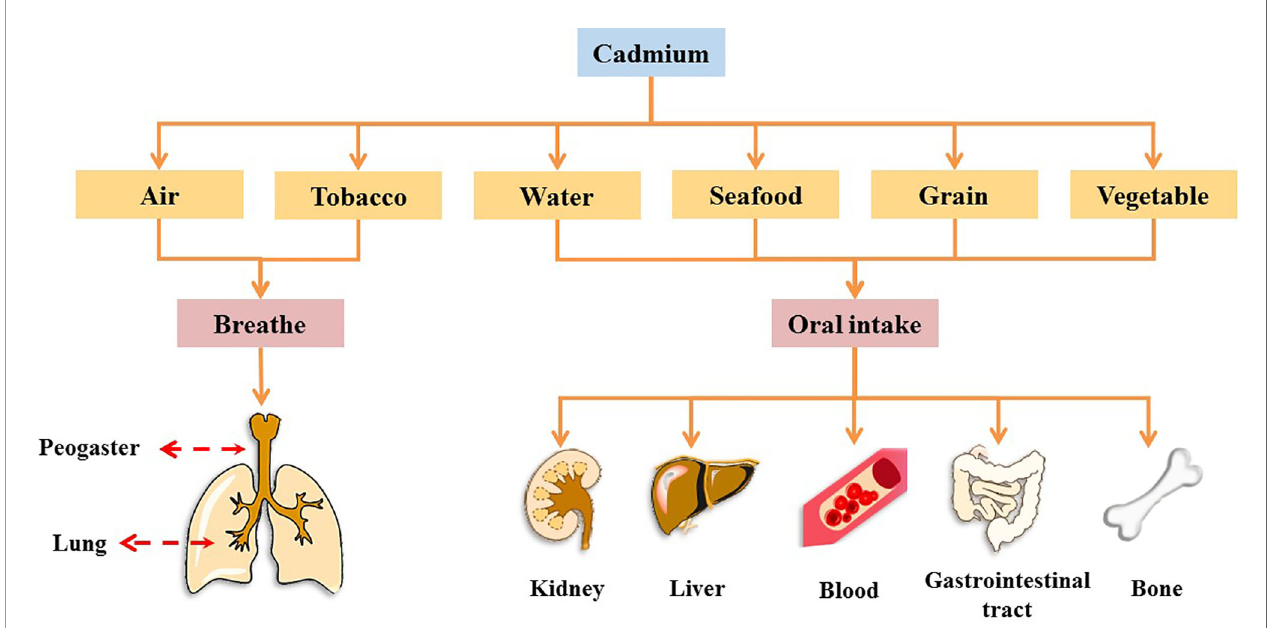
FIGURE 1 | Major routes of Cd exposure and toxic effects of Cd on different organs in the human